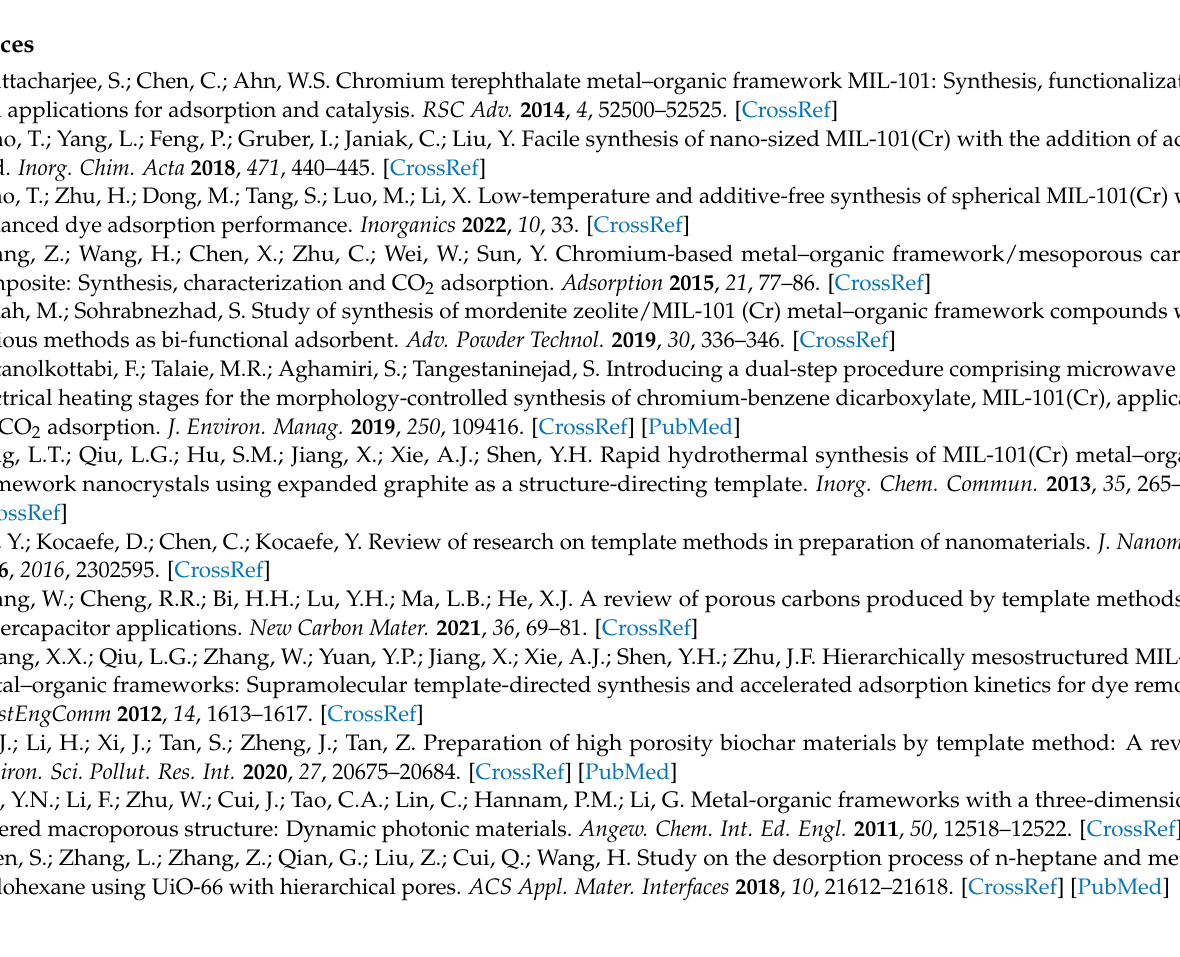
brilliant blue dye; Figure S3: Zeta potential of A-4; Table S1: Fitting parameters of Langmuir, Freundlich, and Temkin models for sample A-4; Figure S4: Cycle adsorption efficiency of A-4 adsorbed